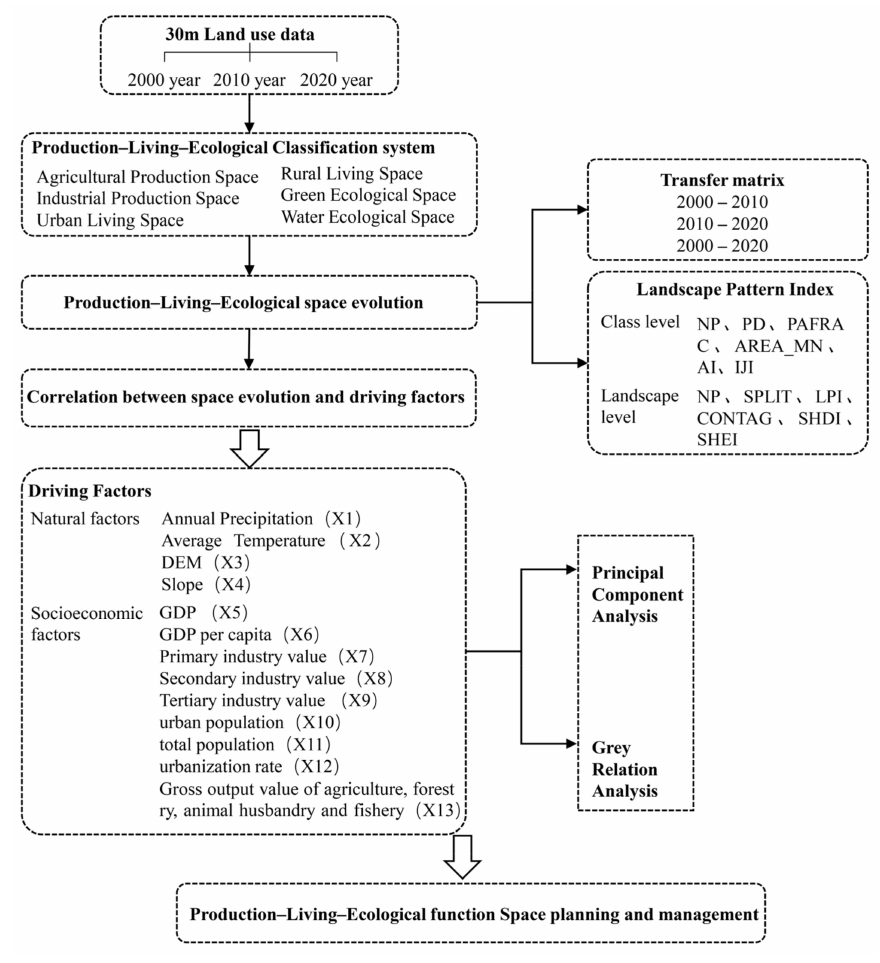
Figure 2. The overall process of the